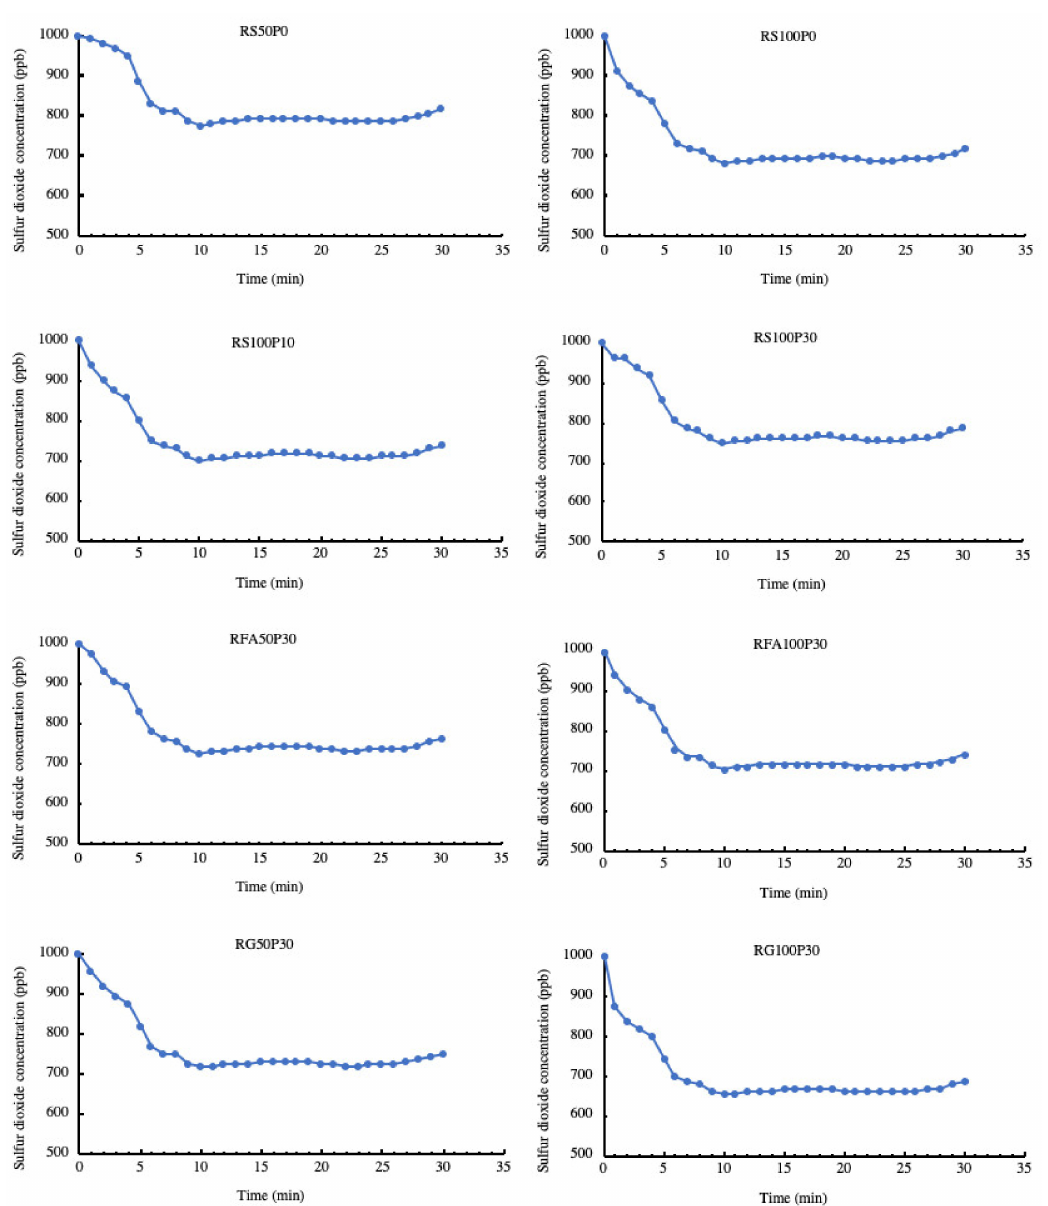
Figure 9. Sulfur dioxide concentration profiles: real time concentration of sulfur